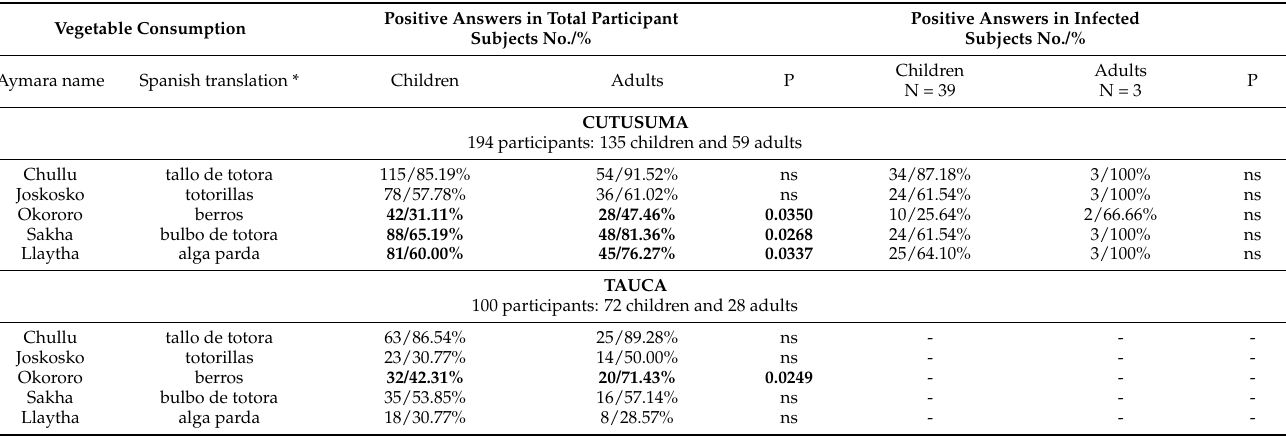
Table 4. Age group comparison (2–15-year-old children vs. 25–76-year-old adult subjects) in the analysis (Fisher’s exact test) of positive answers on vegetable food habits by inhabitants of the localities of Cutusuma and Tauca in the Northern Bolivian Altiplano human fascioliasis hyperendemic area, potentially related to fascioliasis transmission and human fascioliasis. Significant differences highlighted in